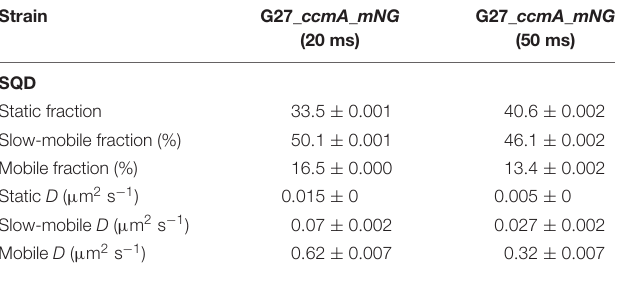
TABLE 2 | Summary of CcmA_mNG single-molecule dynamics acquired with 20- and 50-ms exposure time according to squared displacement analysis